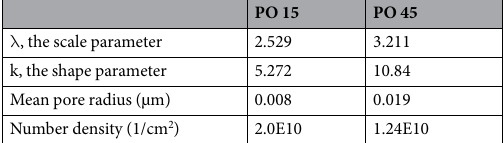
Table 1. Nanoporous surface pores characteristics.